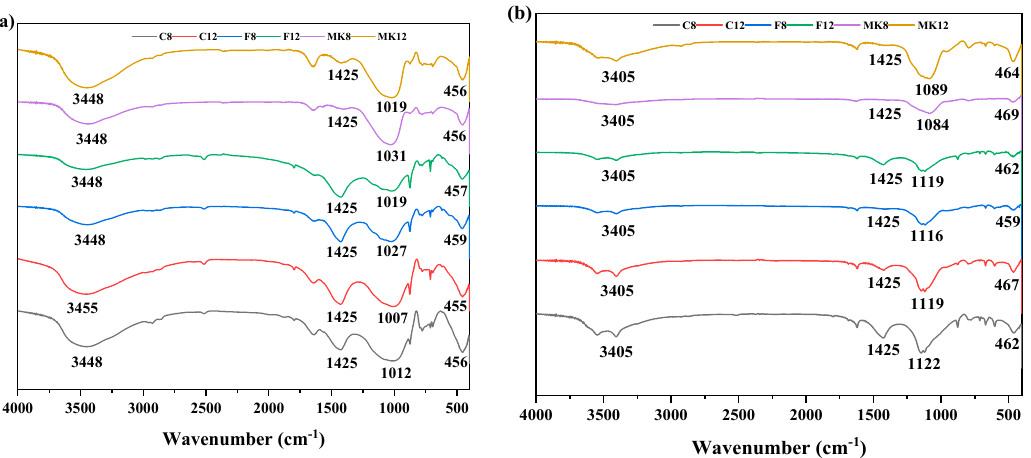
Figure 9. FTIR spectra of GPC exposed to sulfuric acid solution for: ( a ) 0 d; ( b ) 98